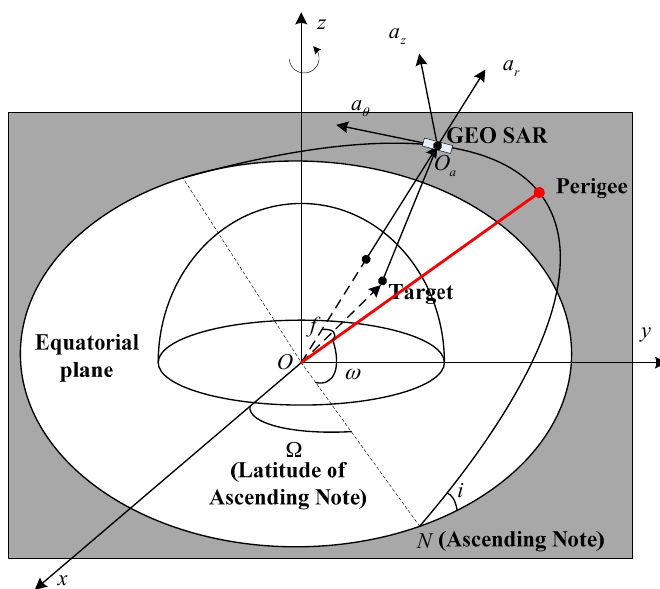
Figure 1. Geometry of the geosynchronous (GEO) SAR imaging. O-xyz is the Earth-centered inertial coordinate system. O a -a r a θ a z is the satellite local coordinate system.